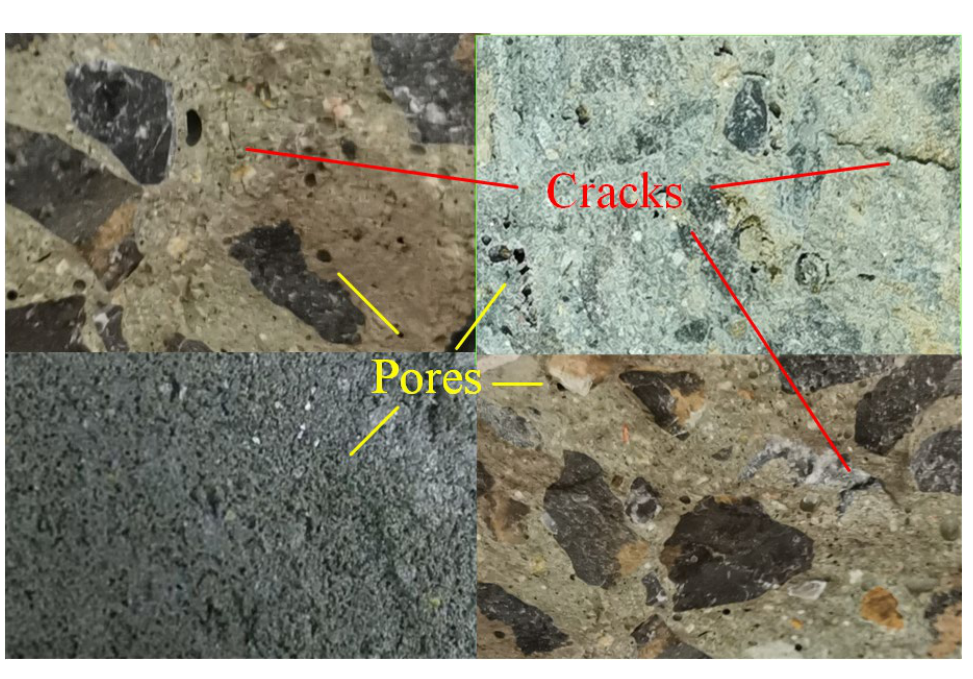
Figure 5. Trend curve of samples strength versus particle sizes (28 days).